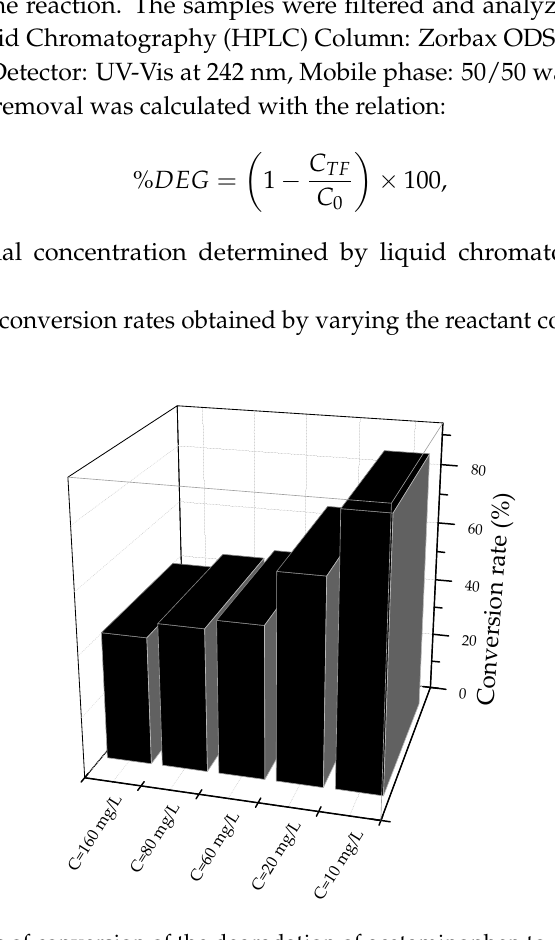
Figure 5. Percentages of conversion of the degradation of acetaminophen to different concentrations (catalyst mass = 1 gr/L, rotational speed = 54 rpm, radiation of λ = 254 nm, number of lamps = 6, reaction volume= 12 L, maximum reaction time = 50 h).